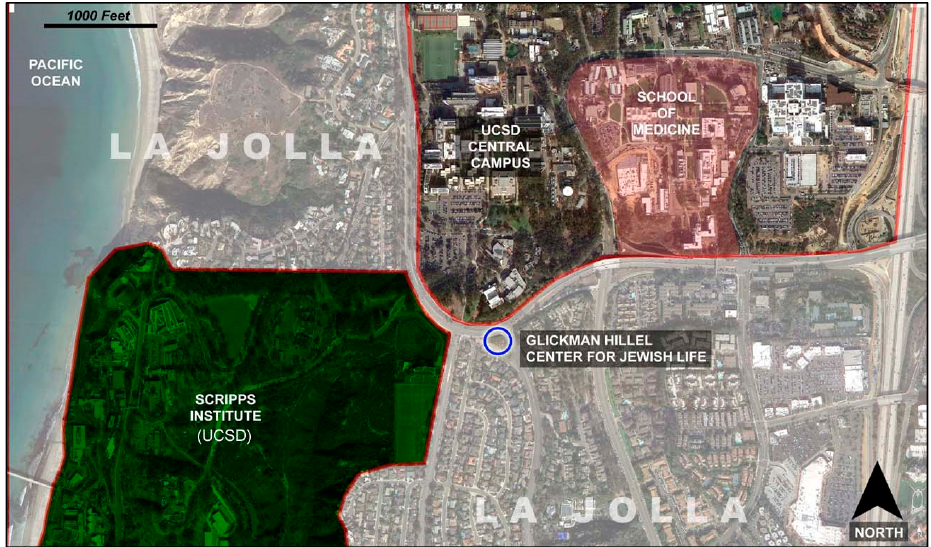
Figure 16. Glickman Hillel Center at UCSD, Location Plan. Image Credits: map data © 2019 Google, TerraMetrics, DataCSUMB SFML, CA OPC; reuse according to Google’s Terms of Service. Annotations by the author.